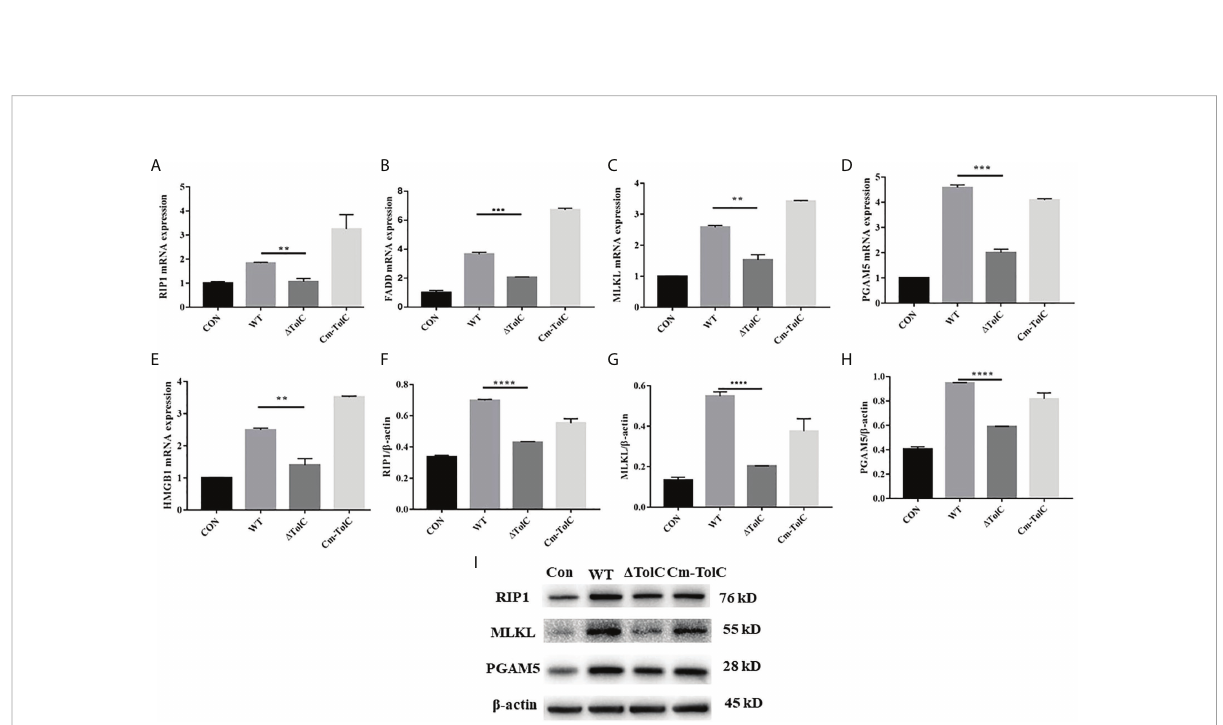
FIGURE 7 Effect of TolC on protsein abundance of necroptsis-related signaling components in PAVECs. (A – E) mRNA abundance of necroptosis signaling components in PAVECs. (F – I) Protein expression of necroptosis signaling components in PAVECs. Statistical analyses were performed using a two unpaired t-test. Statistically signi fi cant difference is indicated as ** p ≤ 0.01, *** p ≤ 0.001 and **** p <